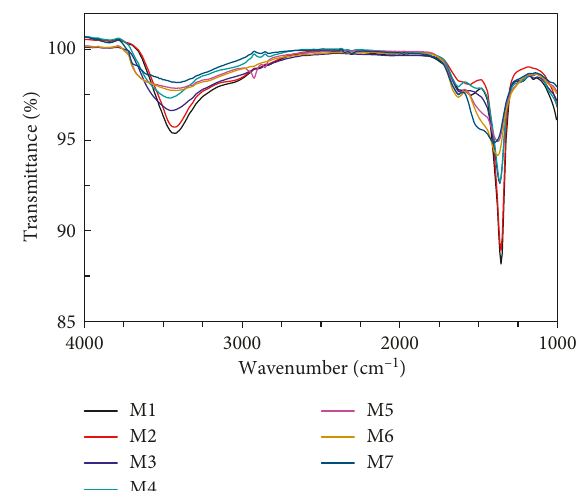
Figure 18: Infrared spectra of the photocatalysts Mg/Al-activated hydrotalcites after photocatalytic degradation of 2,4,6-